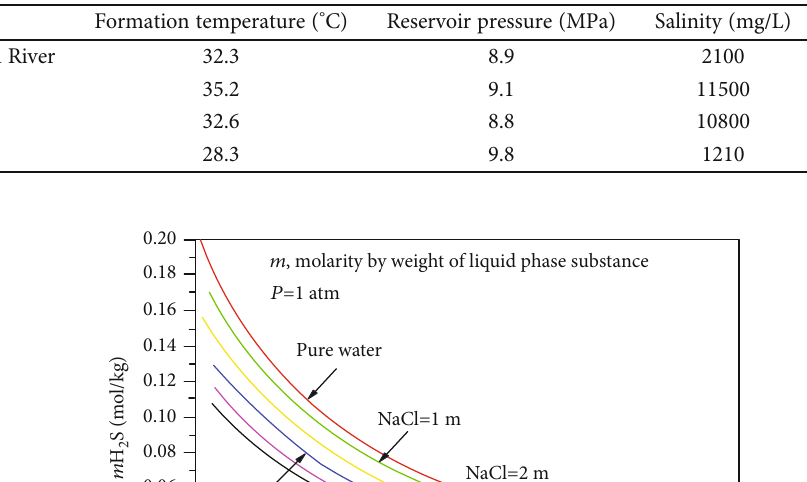
S in the region. 2